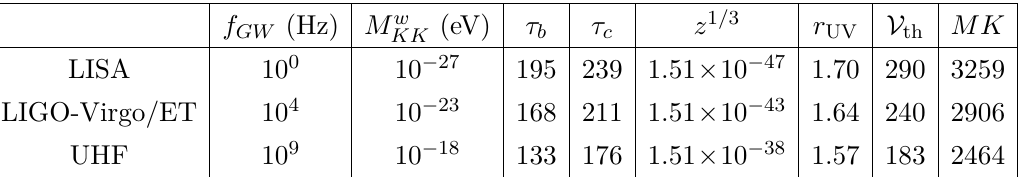
Table 5 . Explicit examples of parameters and scales associated with GW signals covered by LISA, LIGO-Virgo/ET and UHF. We fix H = 10 − 15 and V w = 10 15 in all cases. Lengths and volumes are given in string